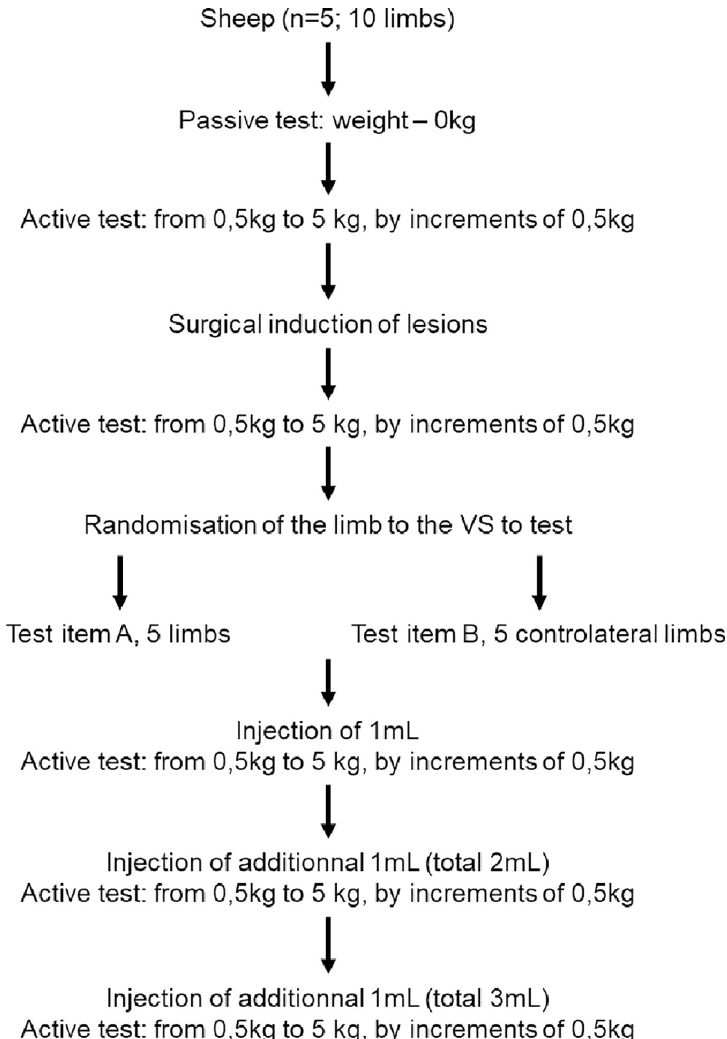
Fig 2. Analytical set-up of the ex-vivo biomechanical study. The experimenter pulled the wire manually (passive test) to check the dispositive. Then the quadriceps was loaded with an initial weight of 0.5 kg and the motion of 3 flexion- extension cycles of the leg was recorded with increasing weight for up to 5 kg by 0.5 kg increment. Test item A = Hylan G-F 20 and test item B = KiOmedine 1 CM- chitosan. weight for up to 5 kg by 0.5 kg increment) after induction of the cartilage defects. The left and right limbs of each sheep were then randomly allocated to the injection of one VS (KiOme- dine 1 CM-Chitosan or Hylan G-F 20) and the controlateral limbs received the second VS (Hylan G-F 20 or KiOmedine 1 CM-Chitosan). Flexion-extension cycles were repeated after every IA injection of increasing volumes of VS (1 mL to 3 mL) (Fig 2). Knee joint kinematics were analyzed in terms of flexion and extension, internal and exter- nal rotation, and cranio-caudal translation of the femur with respect to the tibia, according to the schematic representation of the ex-model described in Fig 4. The cartilage-cartilage COF was determined based on knee joint kinematics. Parameters in damaged cartilage conditions were compared to those in undamaged condition in order to estimate the recovery of joint